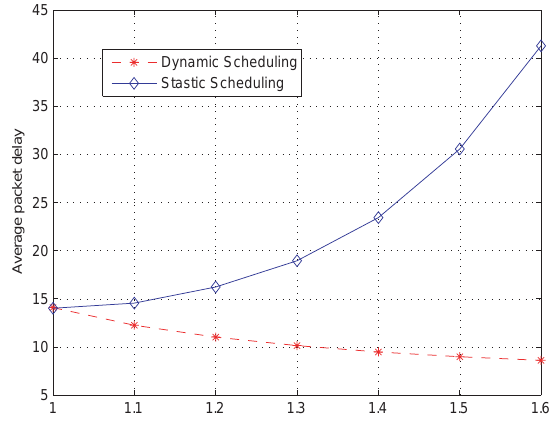
Figure 7. Average Packet Delay vs. ∆ ( M = 8 , p = 0 . 25 ) smaller than that with the static channel